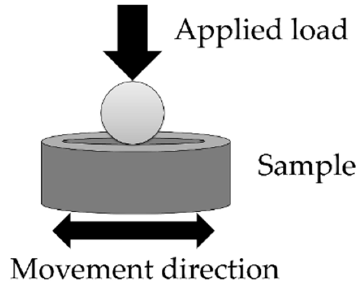
Figure 1. Schematic of the reciprocating ball-on-disc set-up for wear testing.